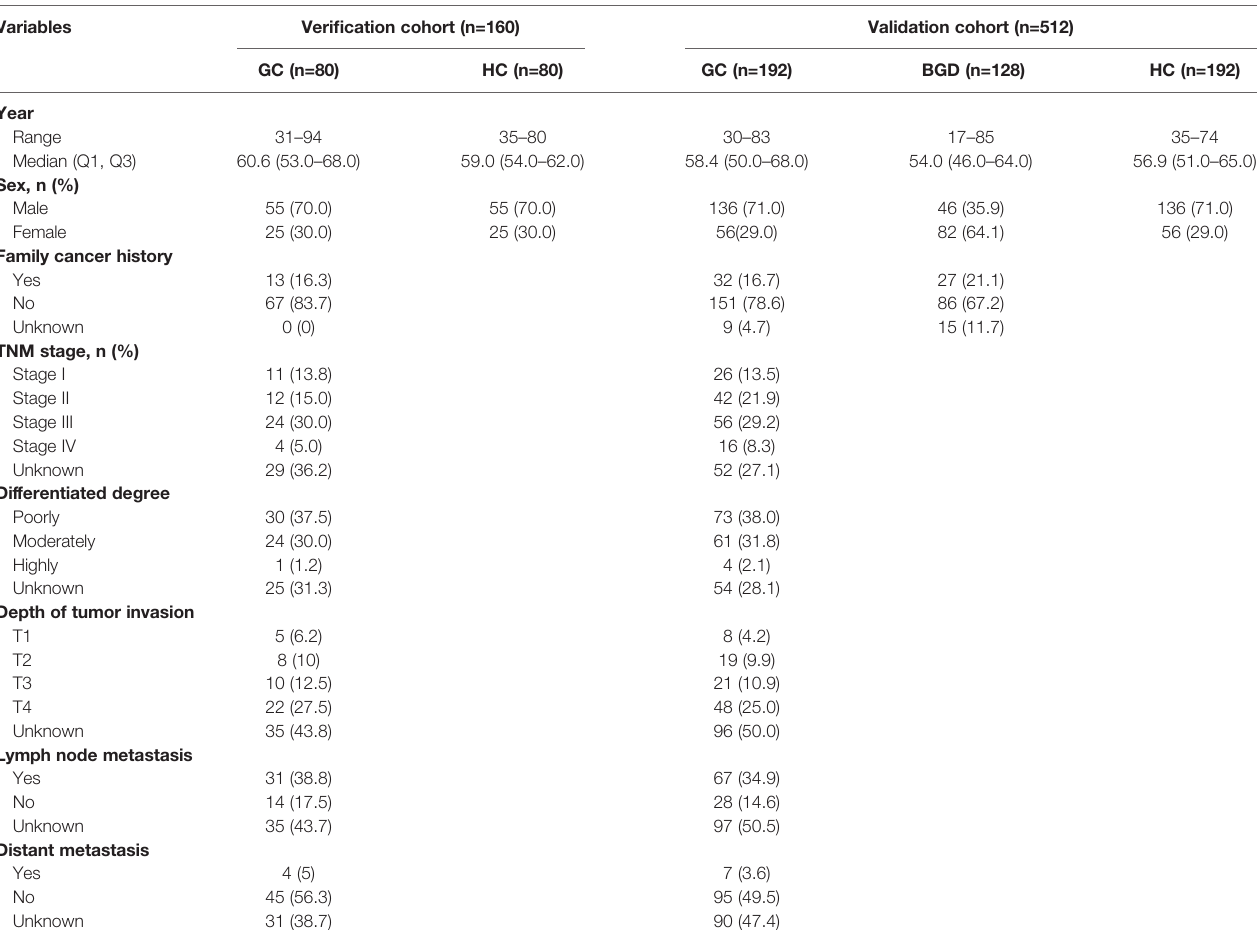
TABLE 1 | Characteristics of all subjects in this